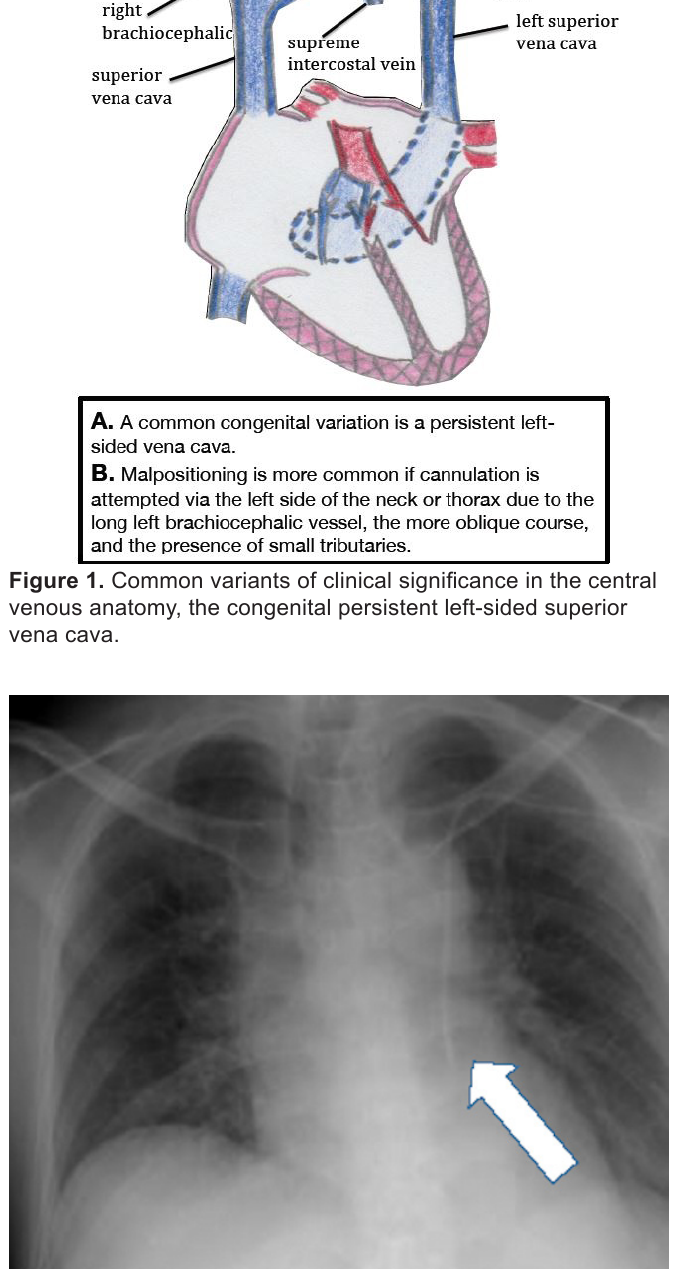
Figure 2. Portable chest radiograph showing a central line inserted in the left subclavian vein, catheter located at persistent left-sided superior vena cava (arrow). Patient was unaware of his congenital variant. He was always asymptomatic during line placement.